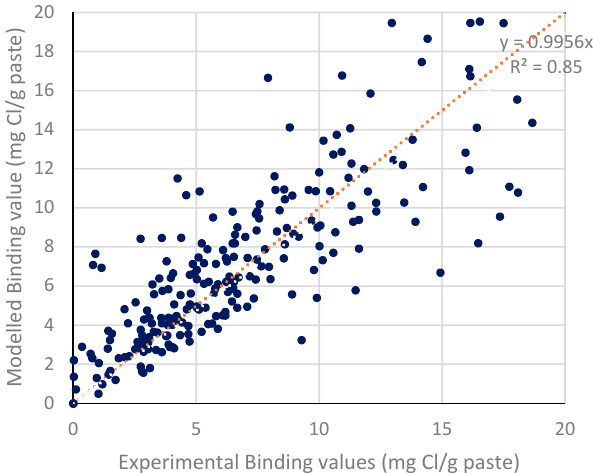
Figure 17. Linear regression analysis of the proposed model versus experimental results in the literature.